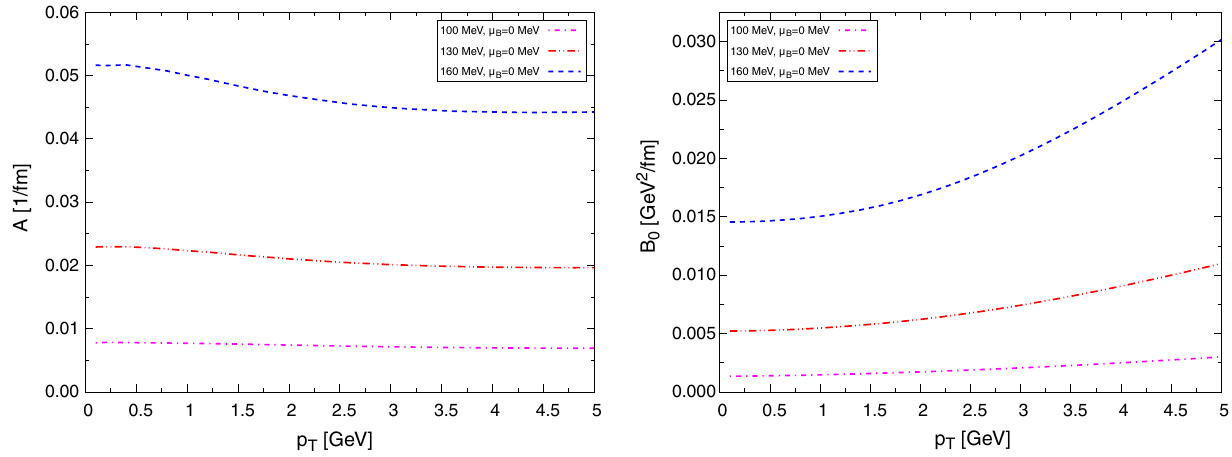
Fig. 3 Drag (left) and diffusion (right) coefficients at different temperatures for D mesons interacting with the pseudoscalar meson octet π , K , ¯ K , η